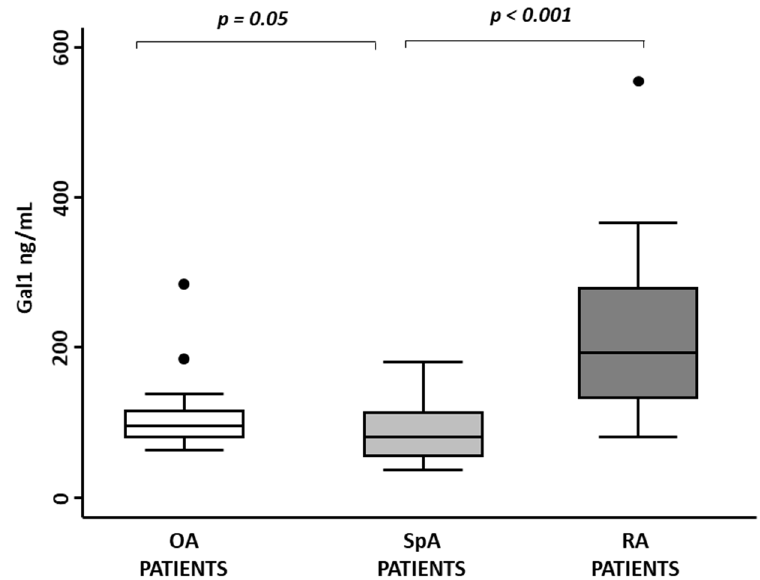
Figure 4. Gal1 synovial fluid levels are different in distinct arthritis populations. Determination of Gal1 synovial fluid levels with ELISA in osteoarthritis (OA) patients, spondyloarthritis (SpA) patients and rheumatoid arthritis (RA) patients. Data are shown as interquartile range (p75 upper edge of box, p25 lower edge, p50 midline) as well as p95 (line above box) and p5 (line below). Dots represent individual values. Statistical significance was determined with ANOVA. Significance threshold was set at p -value < 0.05.